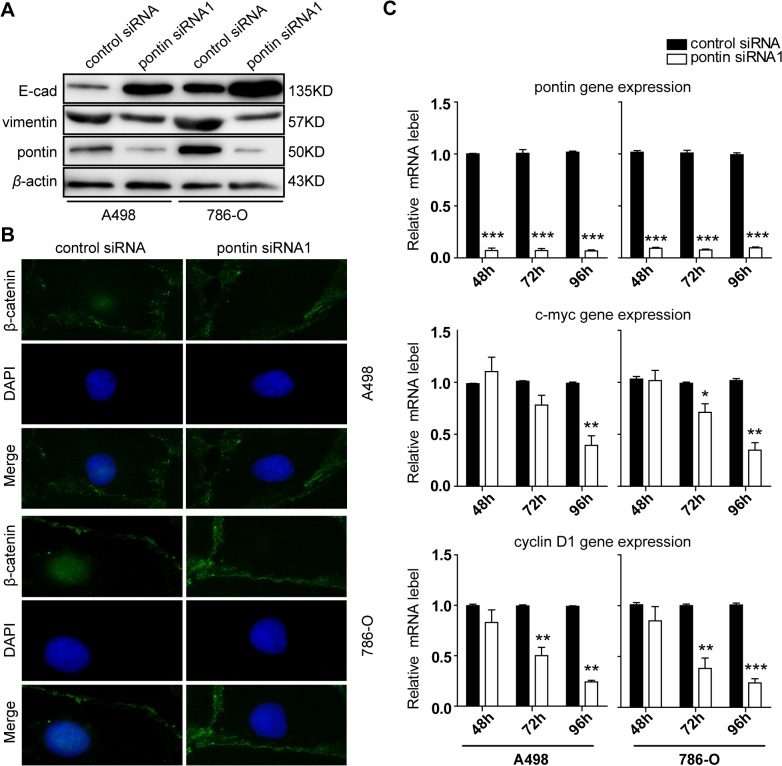
Effects of pontin depletion on the expression of E-cadherin and vimentin, and β-catenin subcellular localization in vitro.(A) Effects on the protein expression of pontin, E-cadherin and vimentin after siRNA transfection for 72 h detected by western blotting. The data shown is representative of 3 independent experiments. (B) The subcellular location of β-catenin was measured by fluorescent immunocytochemical analysis after siRNA transfection for 72 h (green, β-catenin; blue, DAPI nuclear staining). Magnification: ×600. (C) Time dependent changes in mRNA levels of pontin, c-myc and cyclin D1 after siRNA transfection for 48h, 72h and 96h detected by qRT-PCT. Data were shown as mean ± s.e.m. (n = 3). β-actin was used as a loading control. *P<0.05, **P<0.01, ***P<0.001.